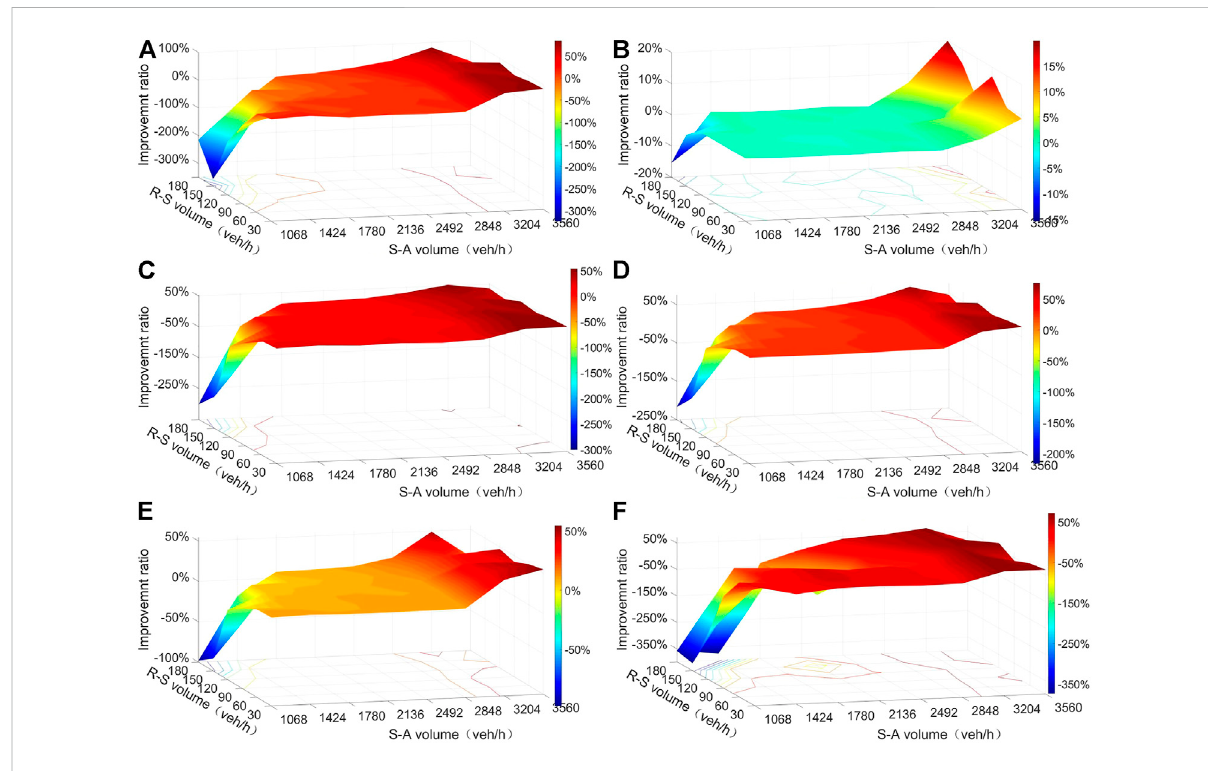
FIGURE 8 Improvement ratio of scheme3, compared with scheme1. (A) Queue length, (B) number of vehicles, (C) delay, (D) number of stops, (E) CO emissions, (F) number of con fl